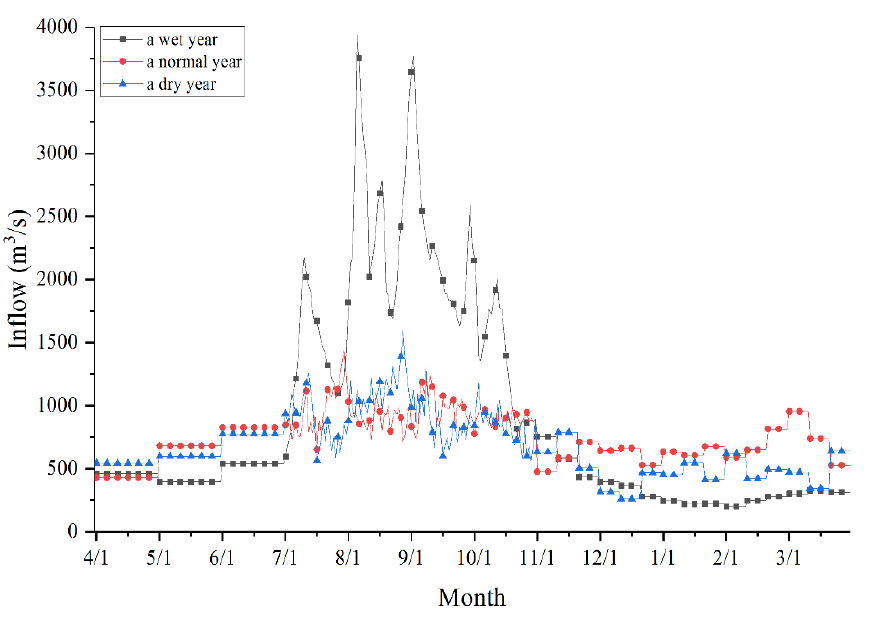
Figure 4. The inflow of the multi-timescale integrated model (MTIM) in a wet year, normal year, and dry year. Table 4. Ecological basic flow in the lower reaches of the Liujiaxia